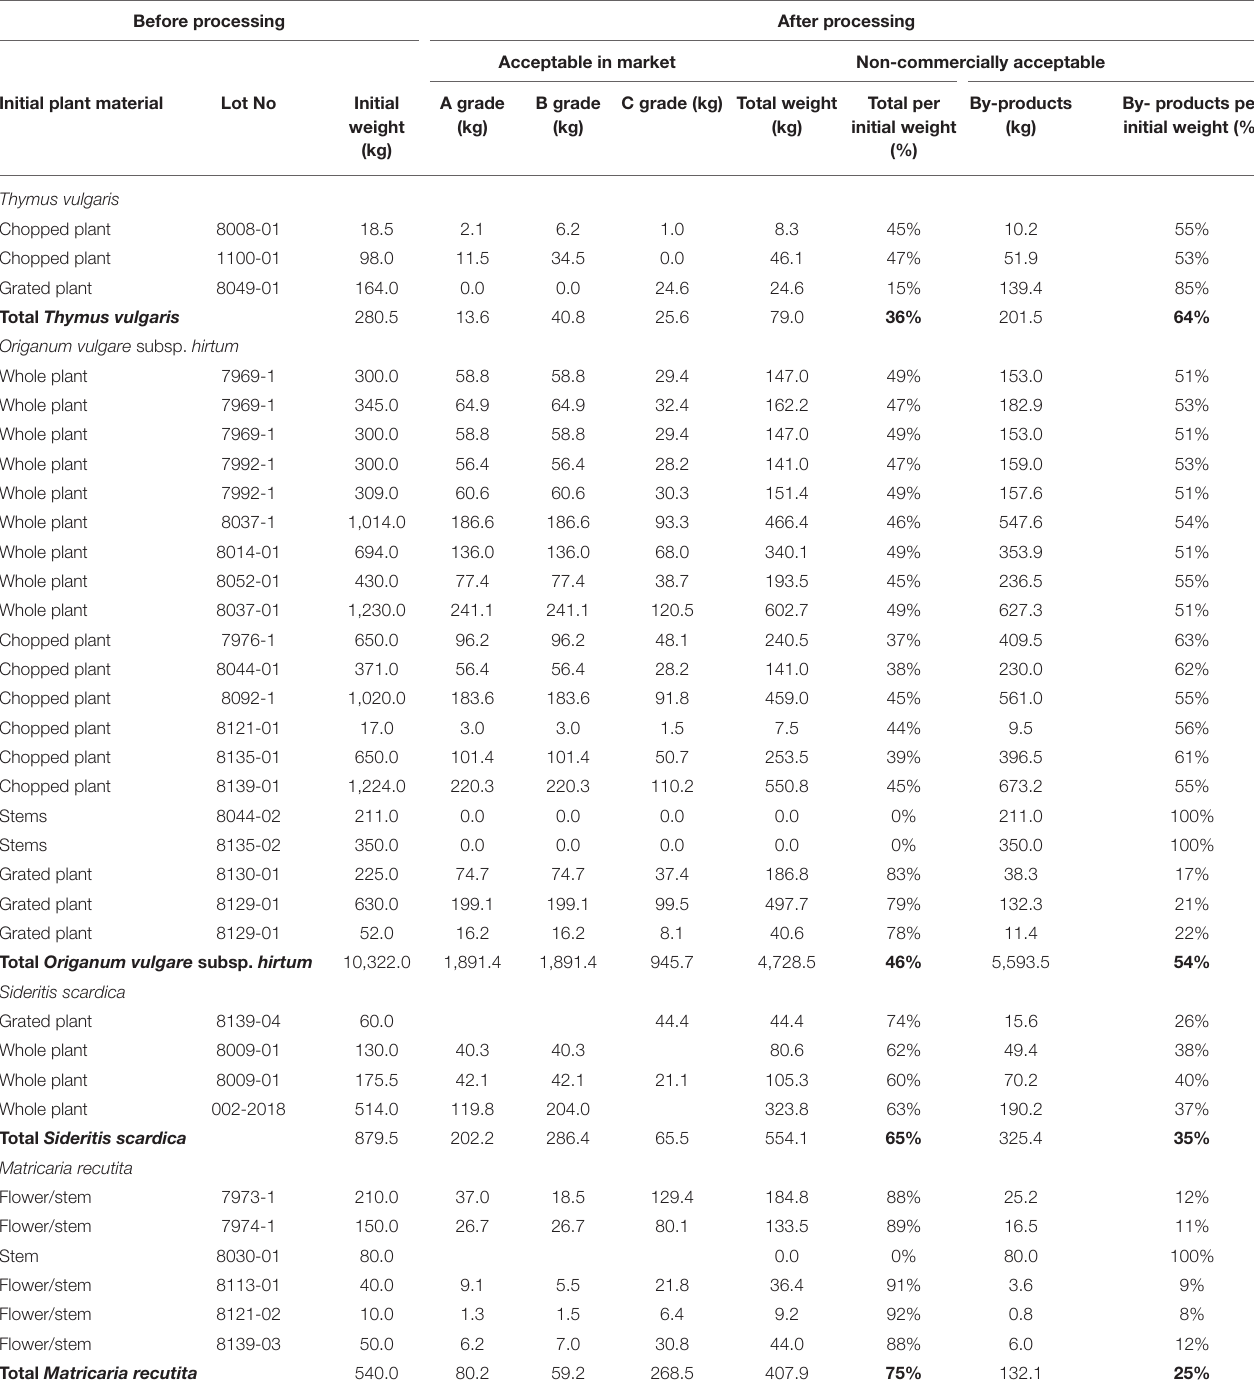
TABLE 1 | Percentages of by-products derived from the cultivated Greek medicinal and aromatic plants’ (MAPs) processing of different lot (between 2018 and 2000 years). Before